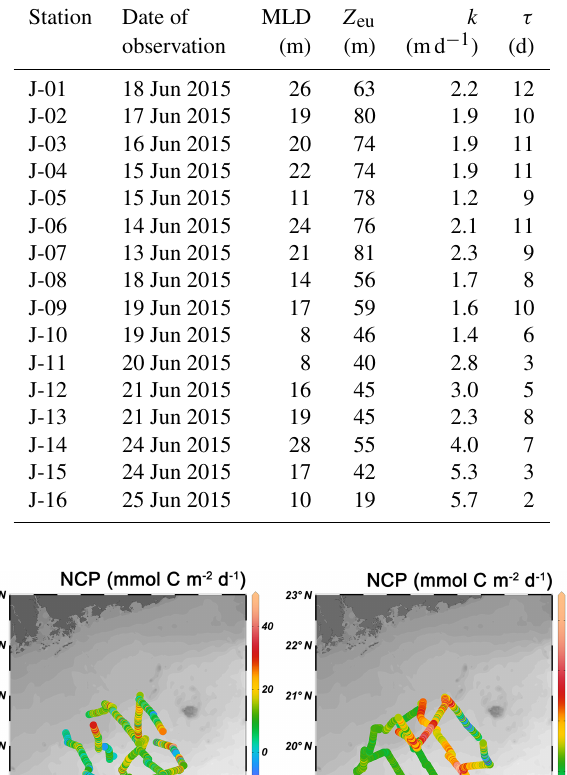
Table 2. Basic information at all CTD stations in June 2015.